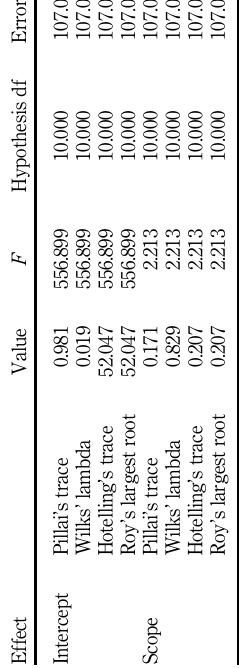
Table 4. Multivariate tests